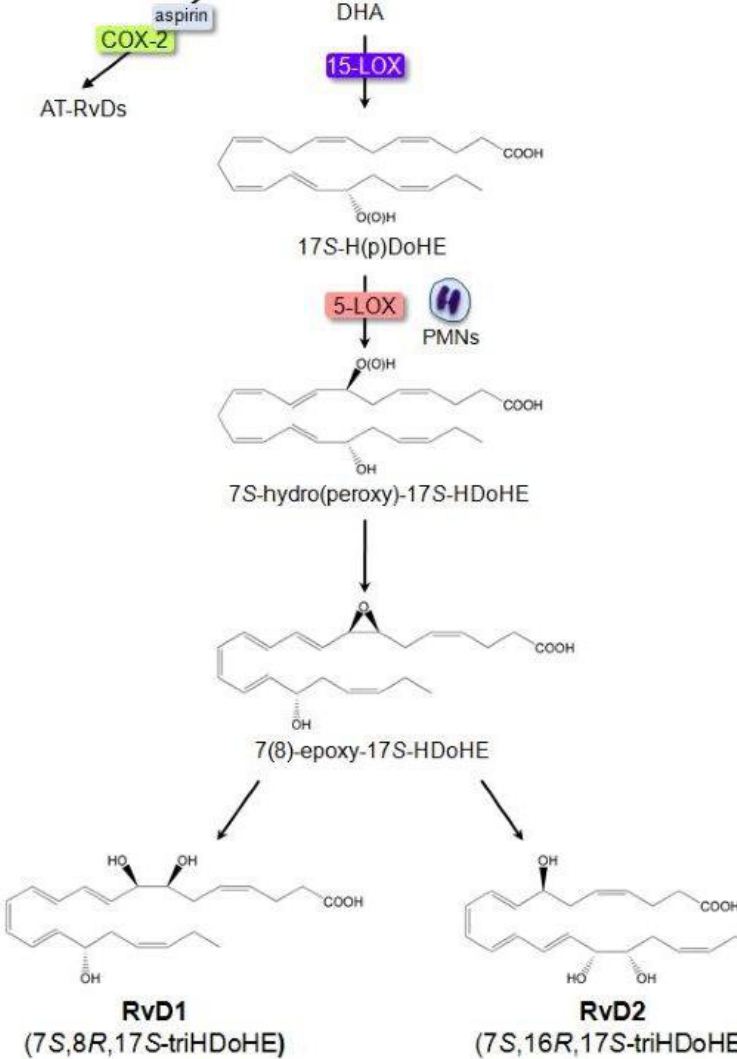
FIGURE 3 . Biosynthetic scheme proposed for D-series resolvins. DHA is the endogenous substrate that is converted into RvDs. DHA is oxygenated at the carbon-17 position via actions of 15-LOX to form 17 S -H(p)DoHE. This metabolite is further converted via sequential actions of leukocyte 5-LOX and leads to the formation of RvD1 and RvD2. DHA is also converted to 17 R -HDoHE by aspirin-acetylated COX-2, which is further converted to aspirin-triggered (AT)-RvDs via 5-LOX activity.